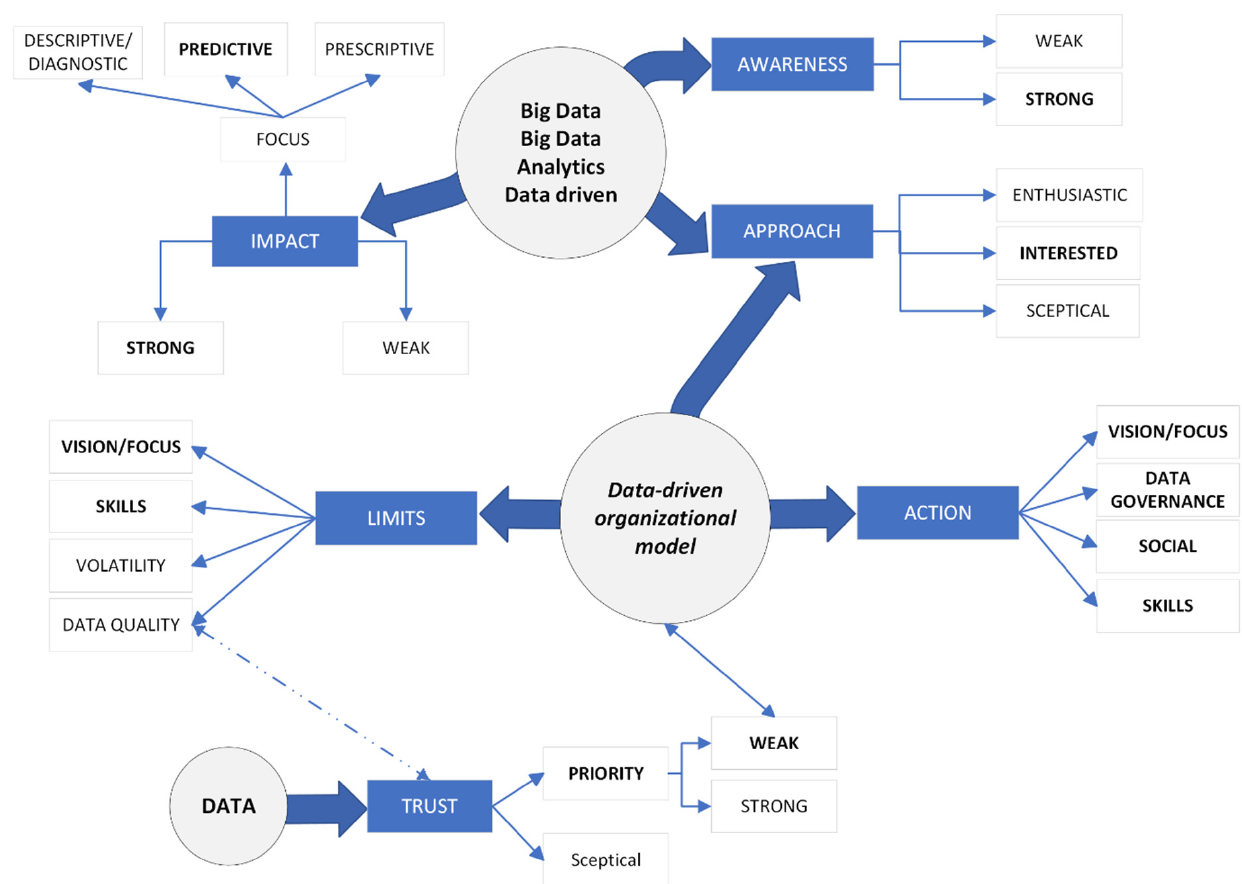
Figure 4. The emergent theoretical model.